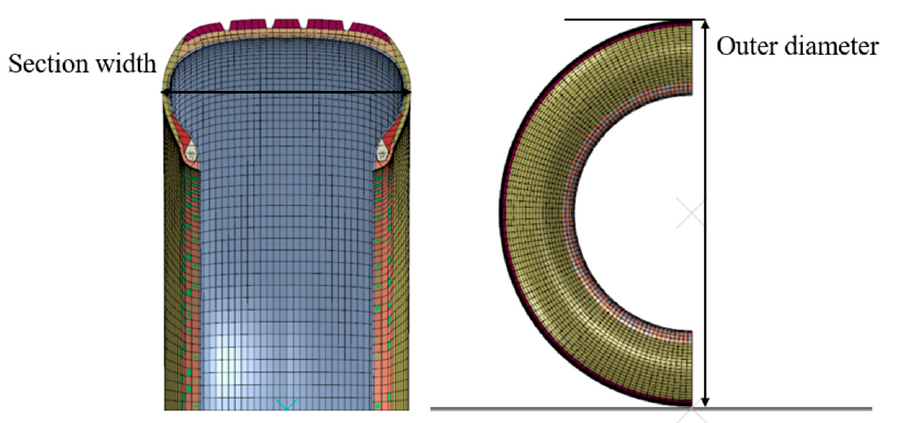
Figure 6. The aircraft tire cross-section under inflation. Table 3. Tire inflation test and simulation results.